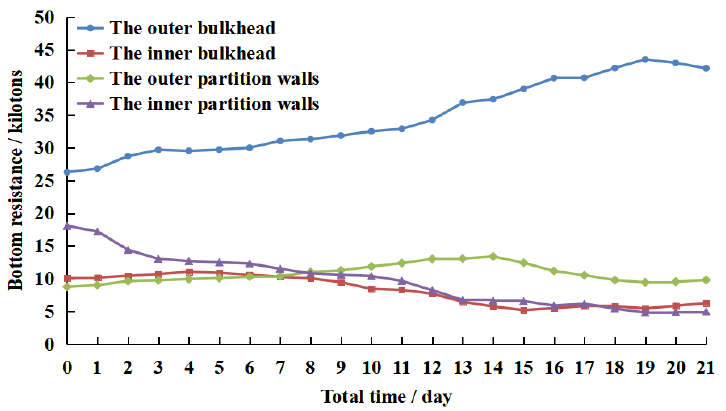
Figure 19. Variation curves of end resistance in different area by field data. From Figure 19, with respect to outer bulkhead, outer partition wall, inner bulkhead and inner partition wall area of the caisson foundation, the end resistances were respectively 26.3 thousand tons, 8.8 thousand tons, 10.1 thousand tons and 18.1 thousand tons before soil excavation. After soil excavation in the inner compartment (step 1), the end